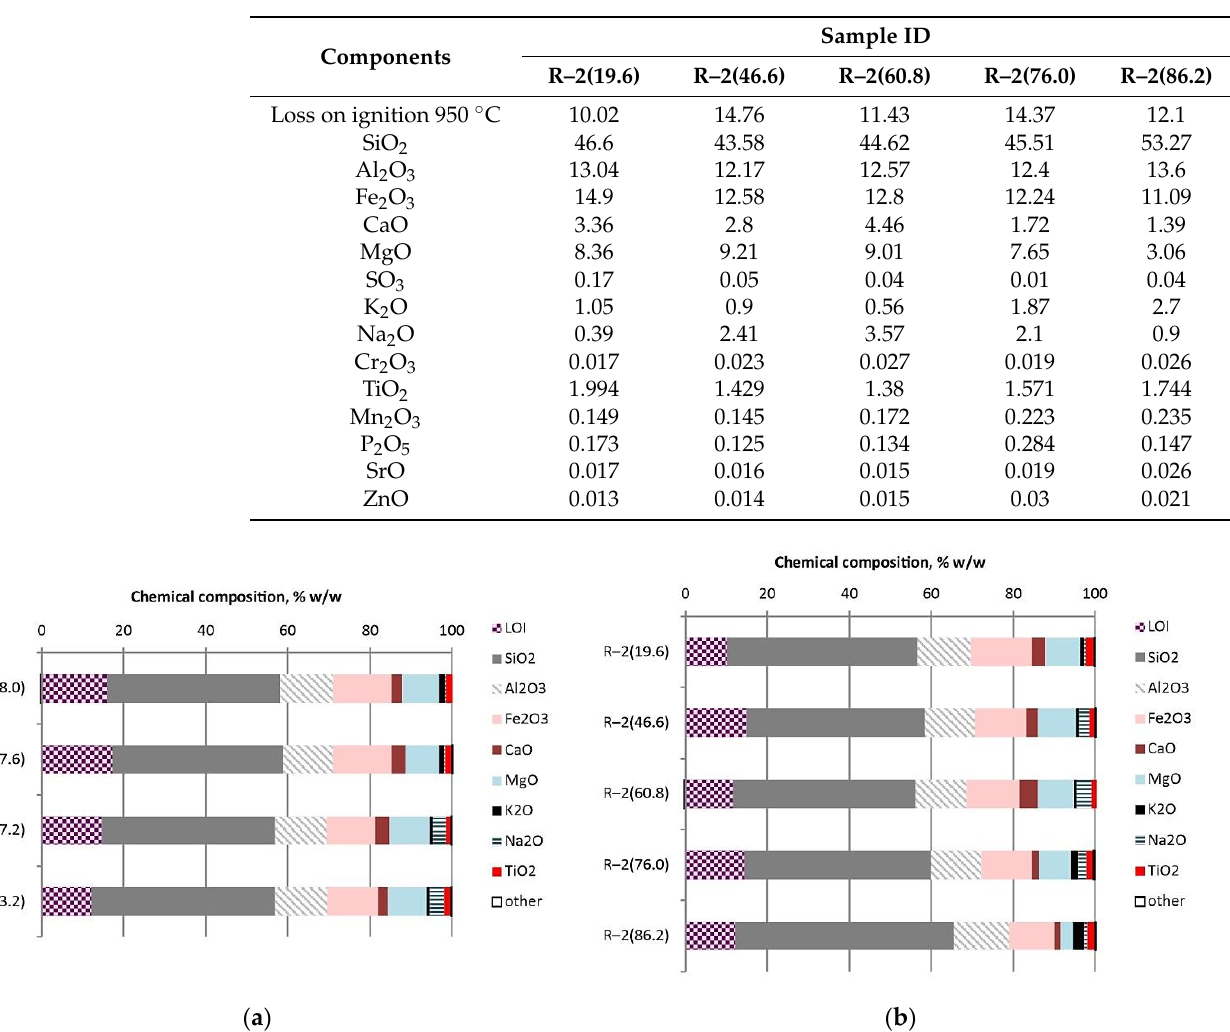
Table 4. Chemical composition of volcanic tuff core samples from Radoshivka–2 well (% w / w ).